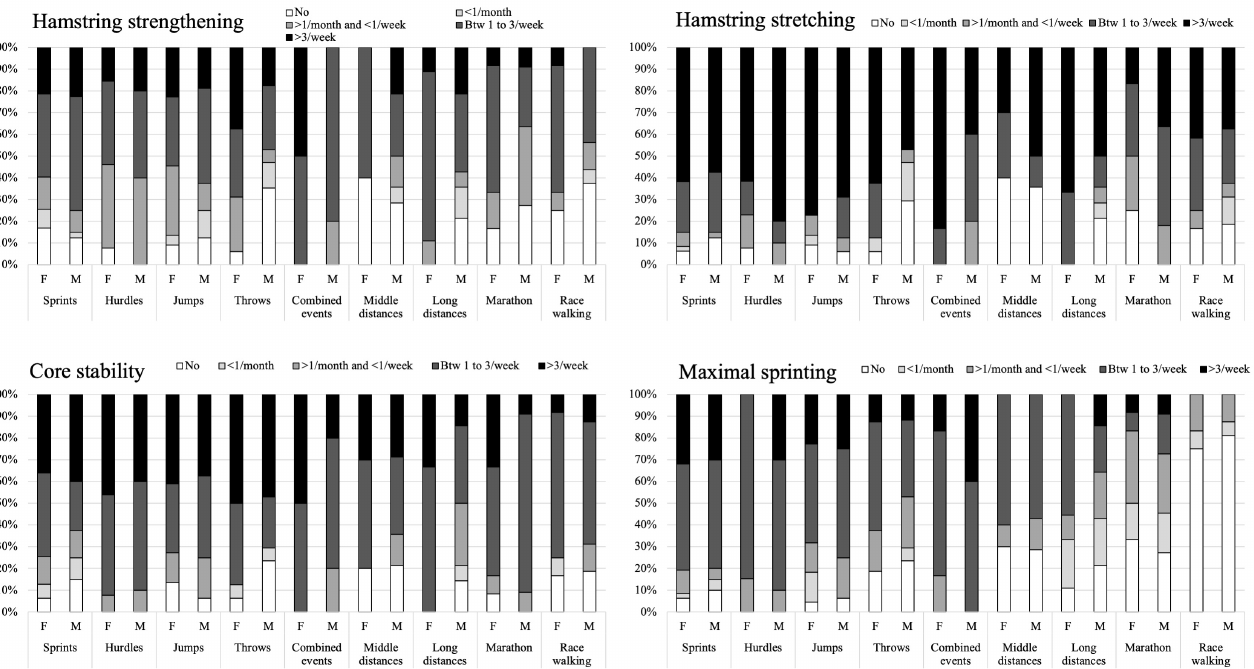
Figure 1. Distribution of hamstring specific training (i.e., hamstring strengthening, hamstring stretch- ing, core stability conditioning and/or sprint running at maximal intensity/velocity) according to sex and discipline (in